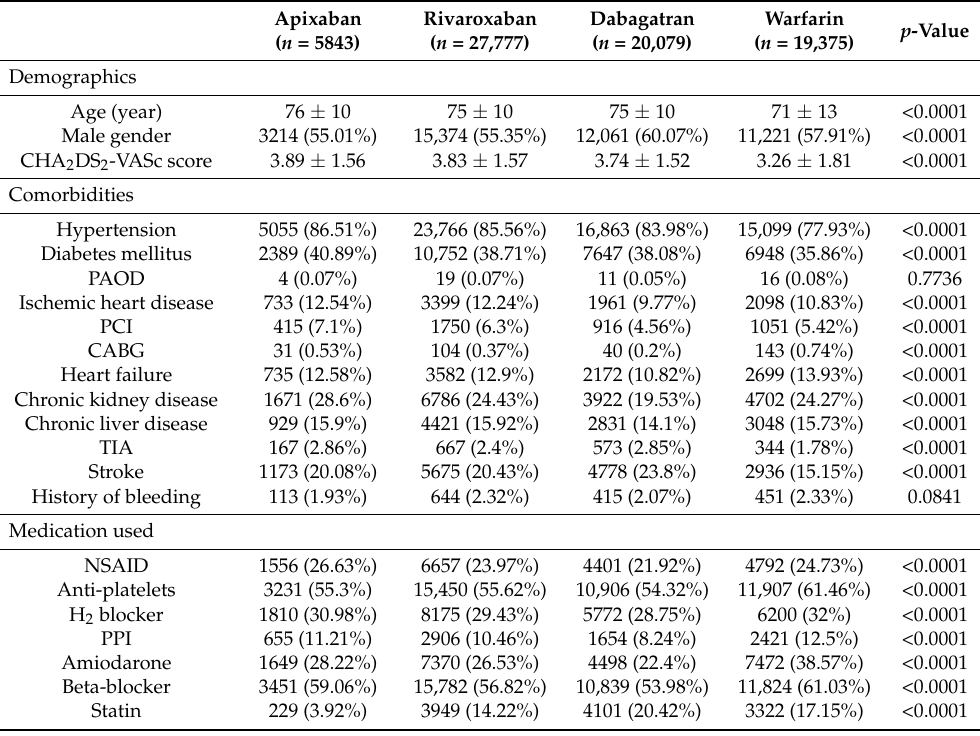
Figure 1. Study flowchart. AF = atrial fibrillation, ESRD = end-stage renal disease. Table 1. Demographic, comorbidities, and medication used among four study